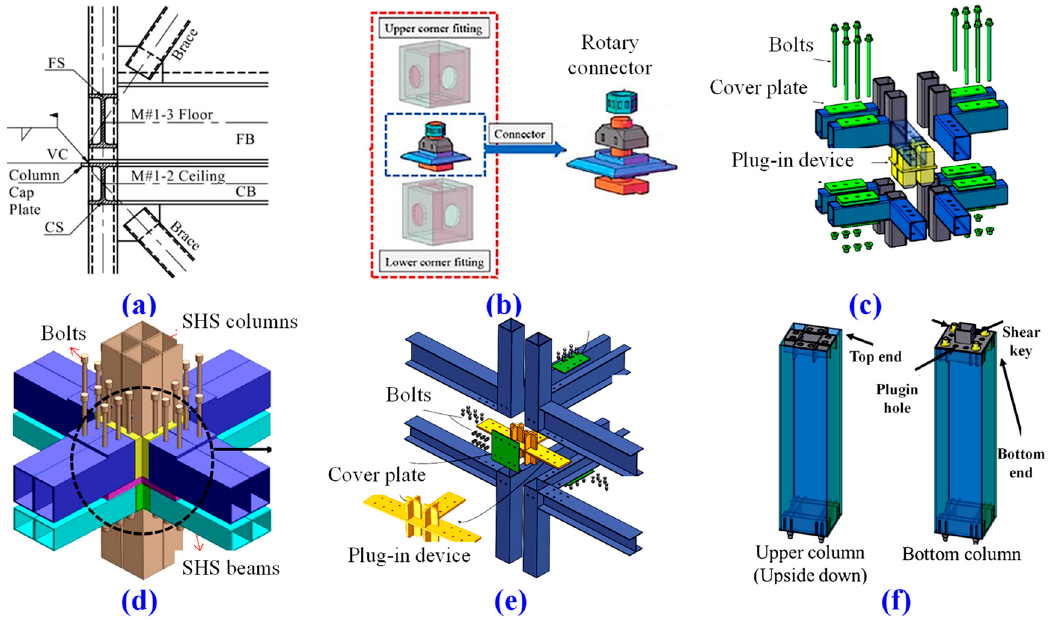
Figure 2. Manual IMC. ( a ) column–column welded [54]; ( b ) rotary connector [60,61,63]; ( c ) beam-beam bolted [66,67]; ( d ) beam-beam and column–column bolted [64]; ( e ) fully bolted plug-in connector [65]; and ( f ) column–column pre-tensioned [68,69] IMC.